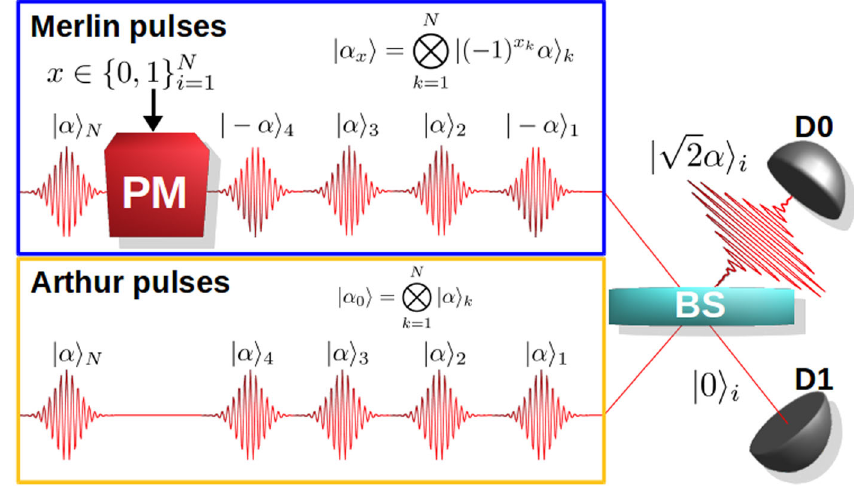
Fig. 1 The Sampling Matching scheme (SM). Merlin creates his coherent state quantum proof by sequentially encoding his proof x into the coherent pulses. Under the SM scheme, Arthur interferes Merlin ’ s coherent state quantum proof with his local state consisting of a sequence of N pulses. He observes the clicks in two single-photon threshold detectors D 0 and D 1 to decide whether Merlin ’ s proof state is